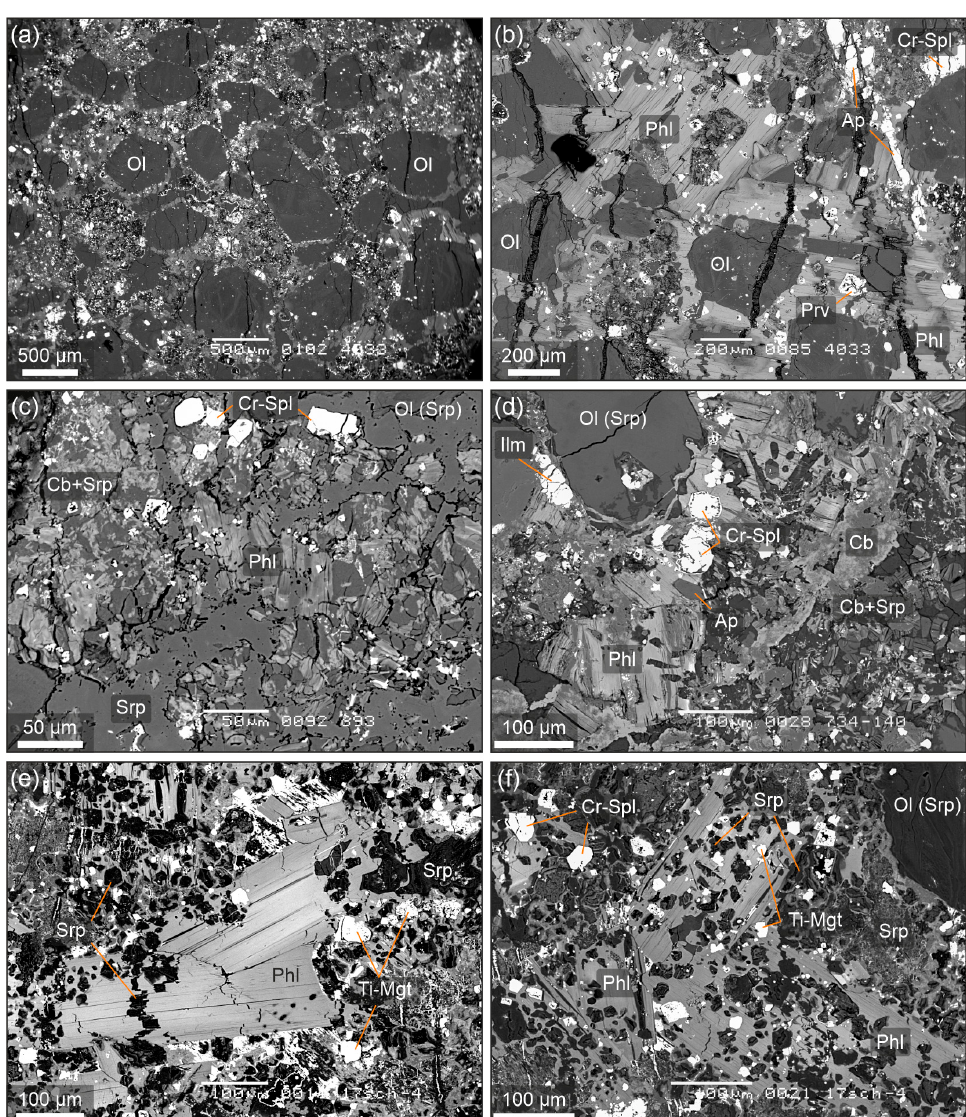
Figure 5. BSE images of coherent porphyritic kimberlite in the Kepino sills: ( a ) the porphyritic texture characterized by euhedral and subhedral olivine grains altered to serpentine and set in the magmatic groundmass consisted of phlogopite, serpentine, spinel rimed by magnetite, apatite, ilmenite, perovskite, rutile, and carbonate (sample 697-4033-1154); ( b ) the hypidiomorphic-granular texture presented by subhedral olivine grains, poikilitic phlogopite grains with inclusions of olivine, oxides, apatite, ilmenite, perovskite, and minor carbonate (sample 697-4033-1154); ( c , d ) two types of phlogopite grains (sample 1219b-276): ( c ) slightly elongated phenocryst grains or their intergrowths; ( d ) phlogopite grains with poikilitic inclusions of titanomagnetite, spinel and irregular inclusions filled by serpentine. ( e ) slightly elongated phlogopite phenocryst grains or their intergrowths; ( f ) phlogopite grains with poikilitic inclusions of titanomagnetite, spinel and irregular inclusions filled by serpentine. Cb—carbonate; Cb + Srp— carbonate-serpentine; Cr-Spl—chromium titanomagnetite.